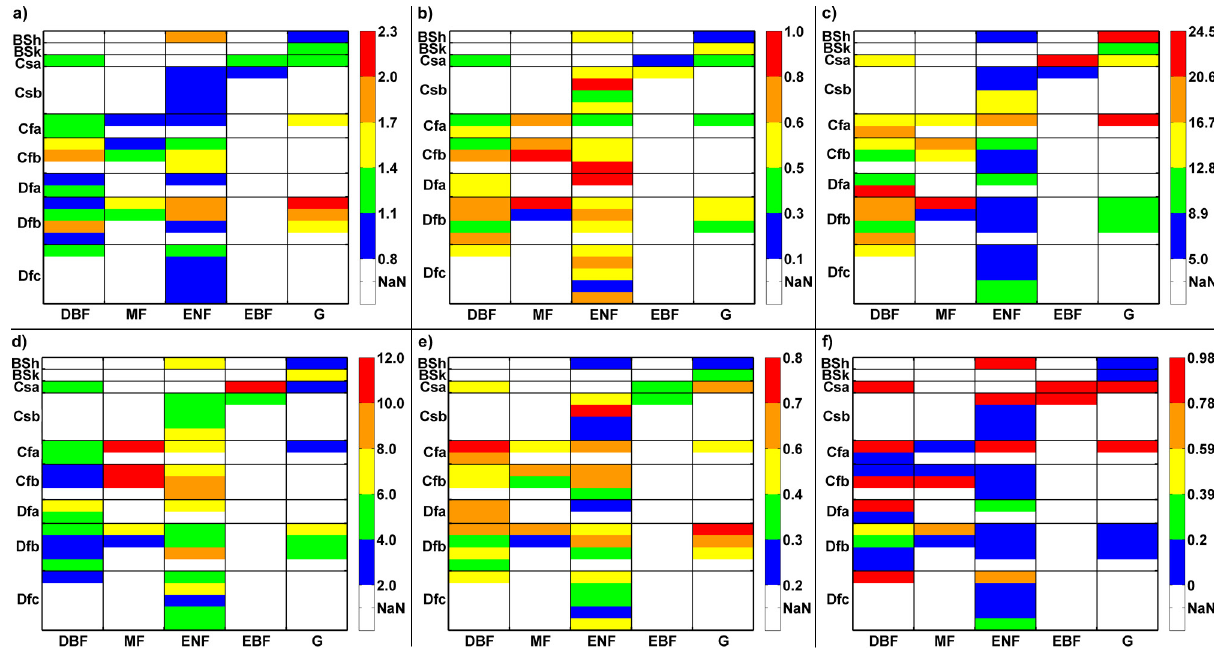
Fig. 8. The six model parameters (cid:15) max (a) , p (b) , T opt (c) , k T (d) , W I (e) , α (f) in a vegetation and climate context. See Fig. 3 for an explanation of the abbreviations.